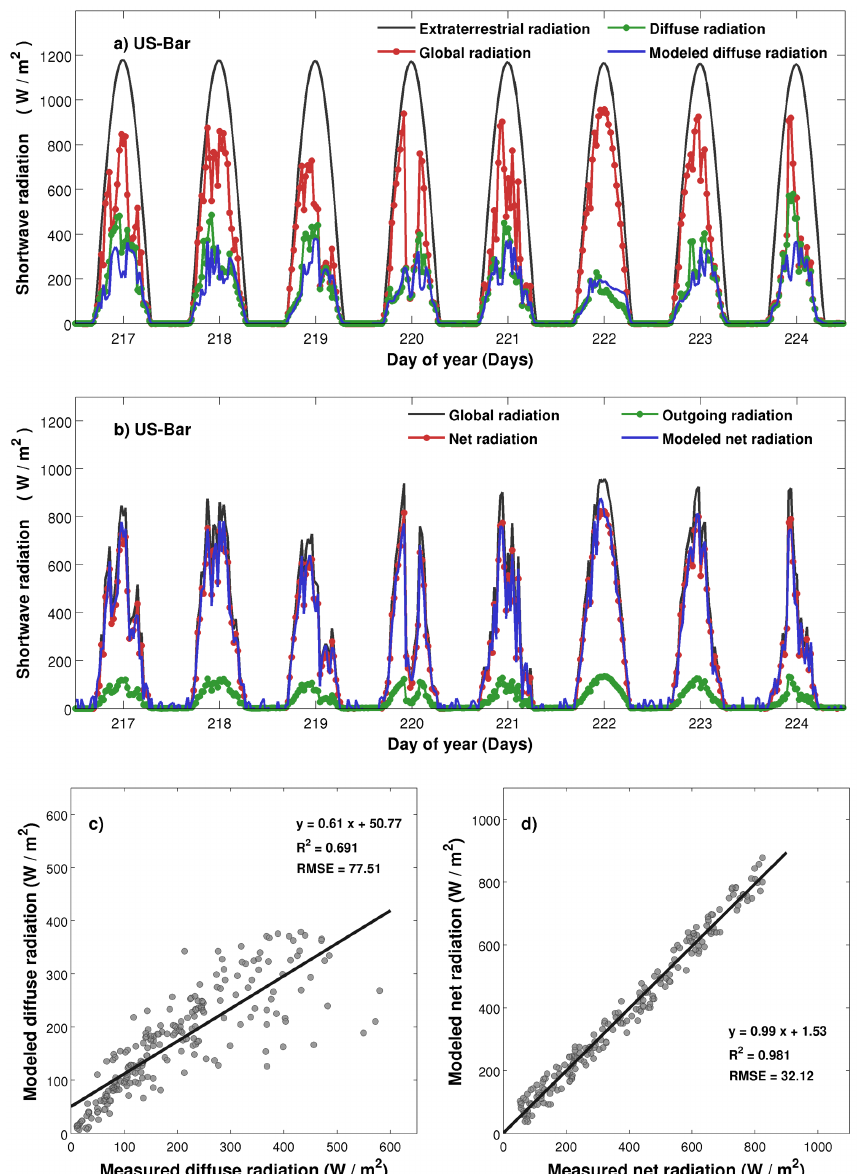
Figure 4. Measured and modeled components of radiation in 8 successive days are shown for (a) the partition of global solar radiation, (b) surface radiation balance, (c) modeled and measured diffuse radiation, and (d) modeled and measured net radiation. Extraterrestrial radiation is derived following methods outlined in Allen et al. (1998). Muneer’s method is applied to model diffuse radiation. The GORT model is applied to model net radiation. Data are shown from DOY 217 to 224 in 2004 for the US-Bar